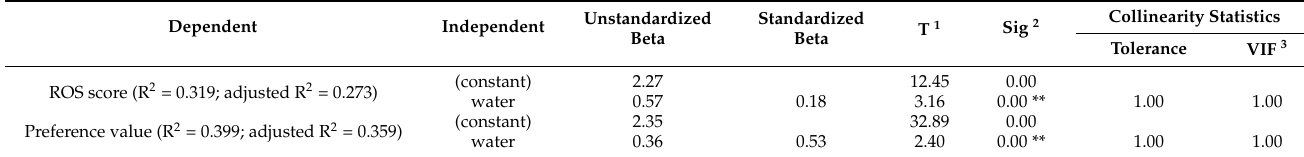
Figure 6. Recovery and preference values of different spatial elements. Table 3. Significant influence of different spatial element stimuli on recovery and preference